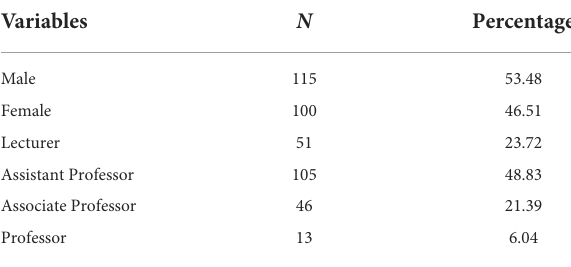
TABLE 1 Demographic information of respondents.